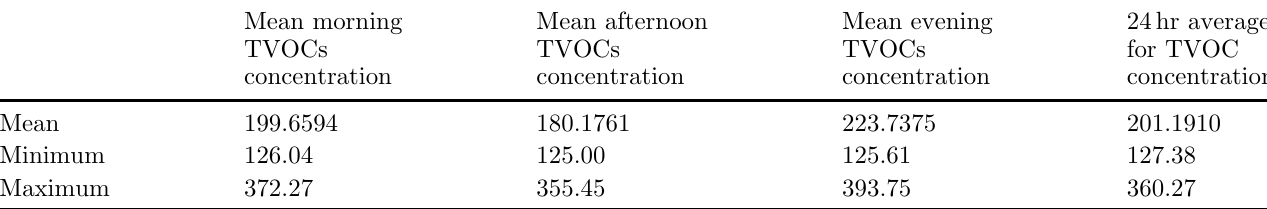
Table 8. Concentration levels of total volatile organic compounds during the dry season.